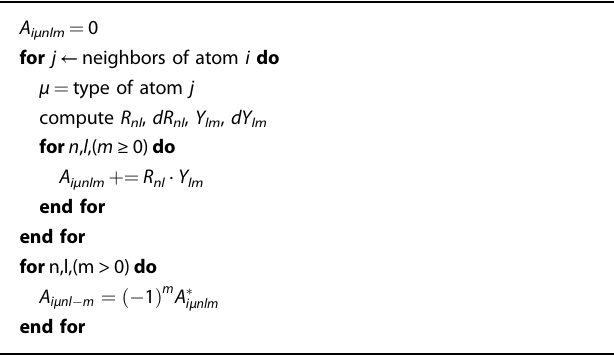
Algorithm 1. Atomic base A